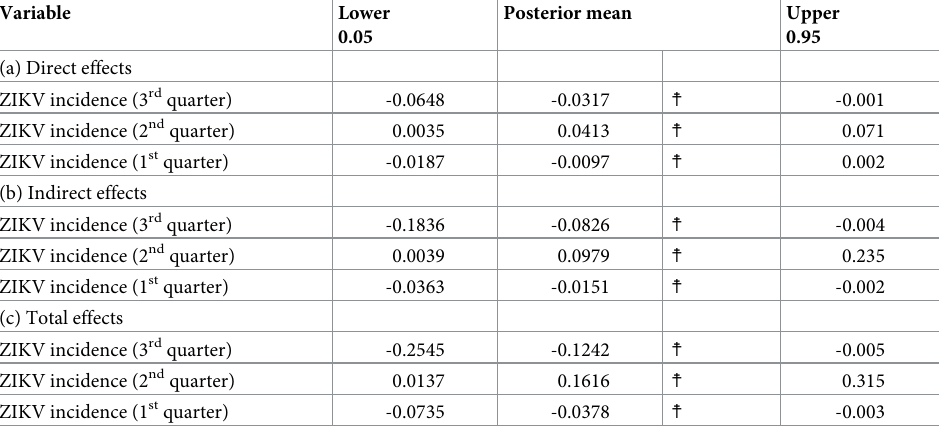
Table 2. Results of SAR Tobit—Direct and indirect effects—Dependent variable: Microcephaly incidence (4 th quarter), Brazil—2016.